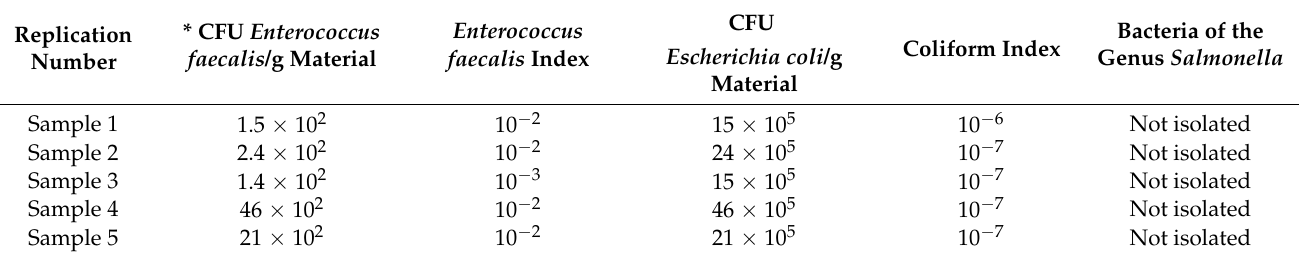
Table 5. The content of pathogenic microorganisms in the fresh compost